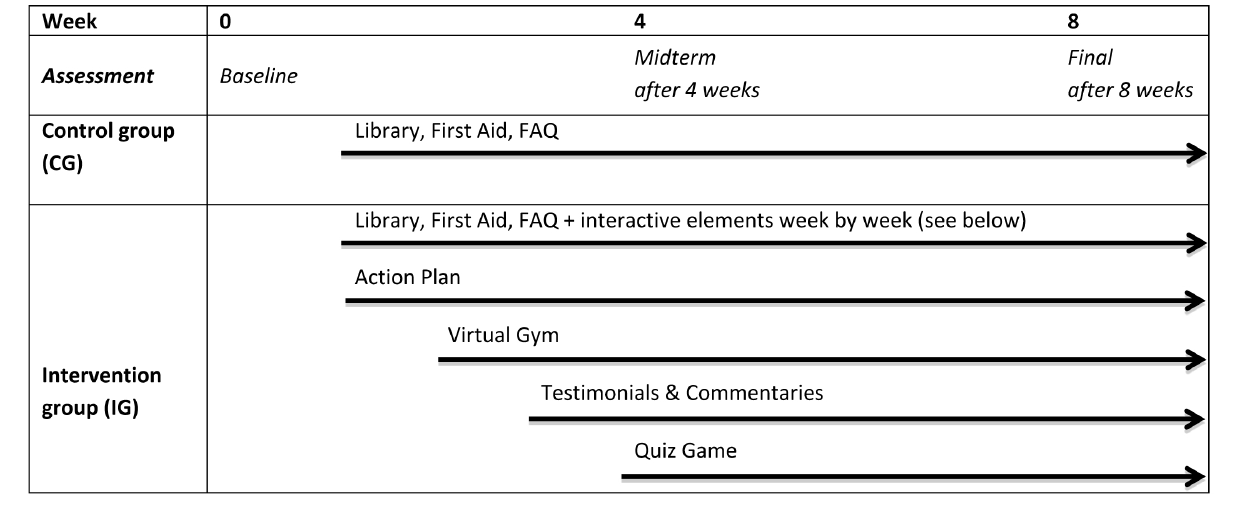
Figure 2. Design and timeline of randomized controlled